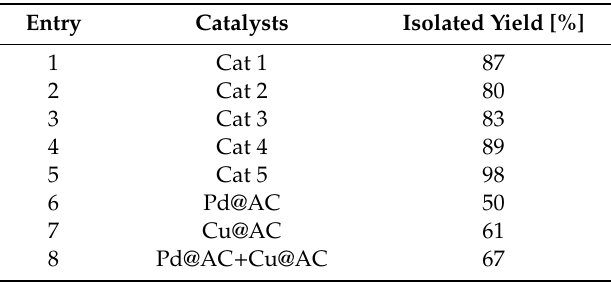
Table 1. Pd / Cu@AC catalyzed cross-coupling of 4-iodotoluene and phenylacetylene.